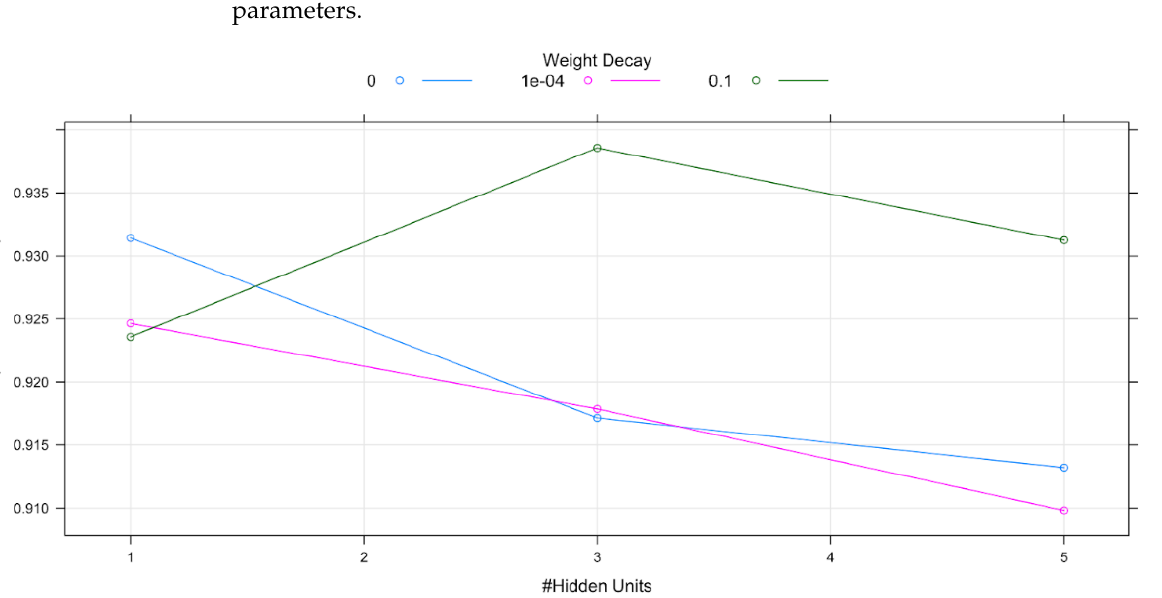
Figure 3. Outline of the study starting from the positioning of the landmarks and semi-landmarks up to the ANN output. PC: principal components.